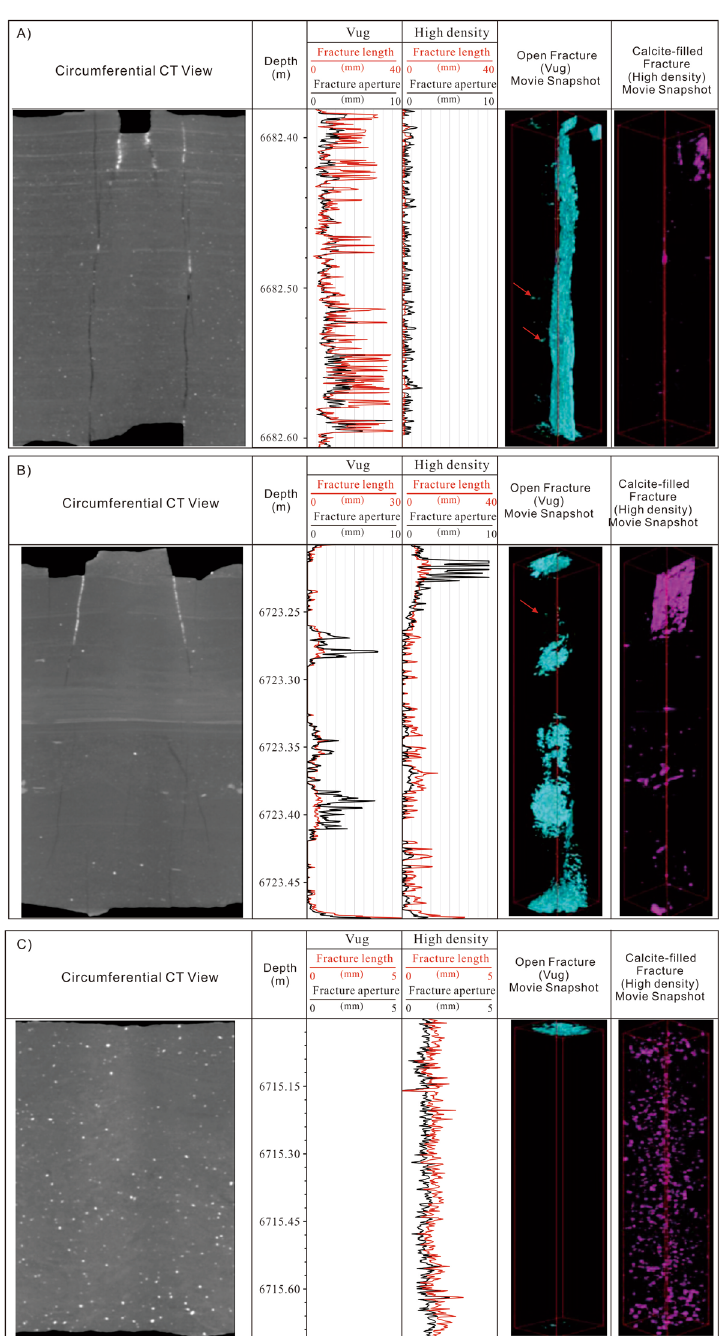
Figure 6. Three-dimensional volume rendering of fractures for Sample ( A ) segment 6682.38; ( B ) segment 6723.2 m; ( C ) segment 6715.00 m. Note the locally distributed pores (red